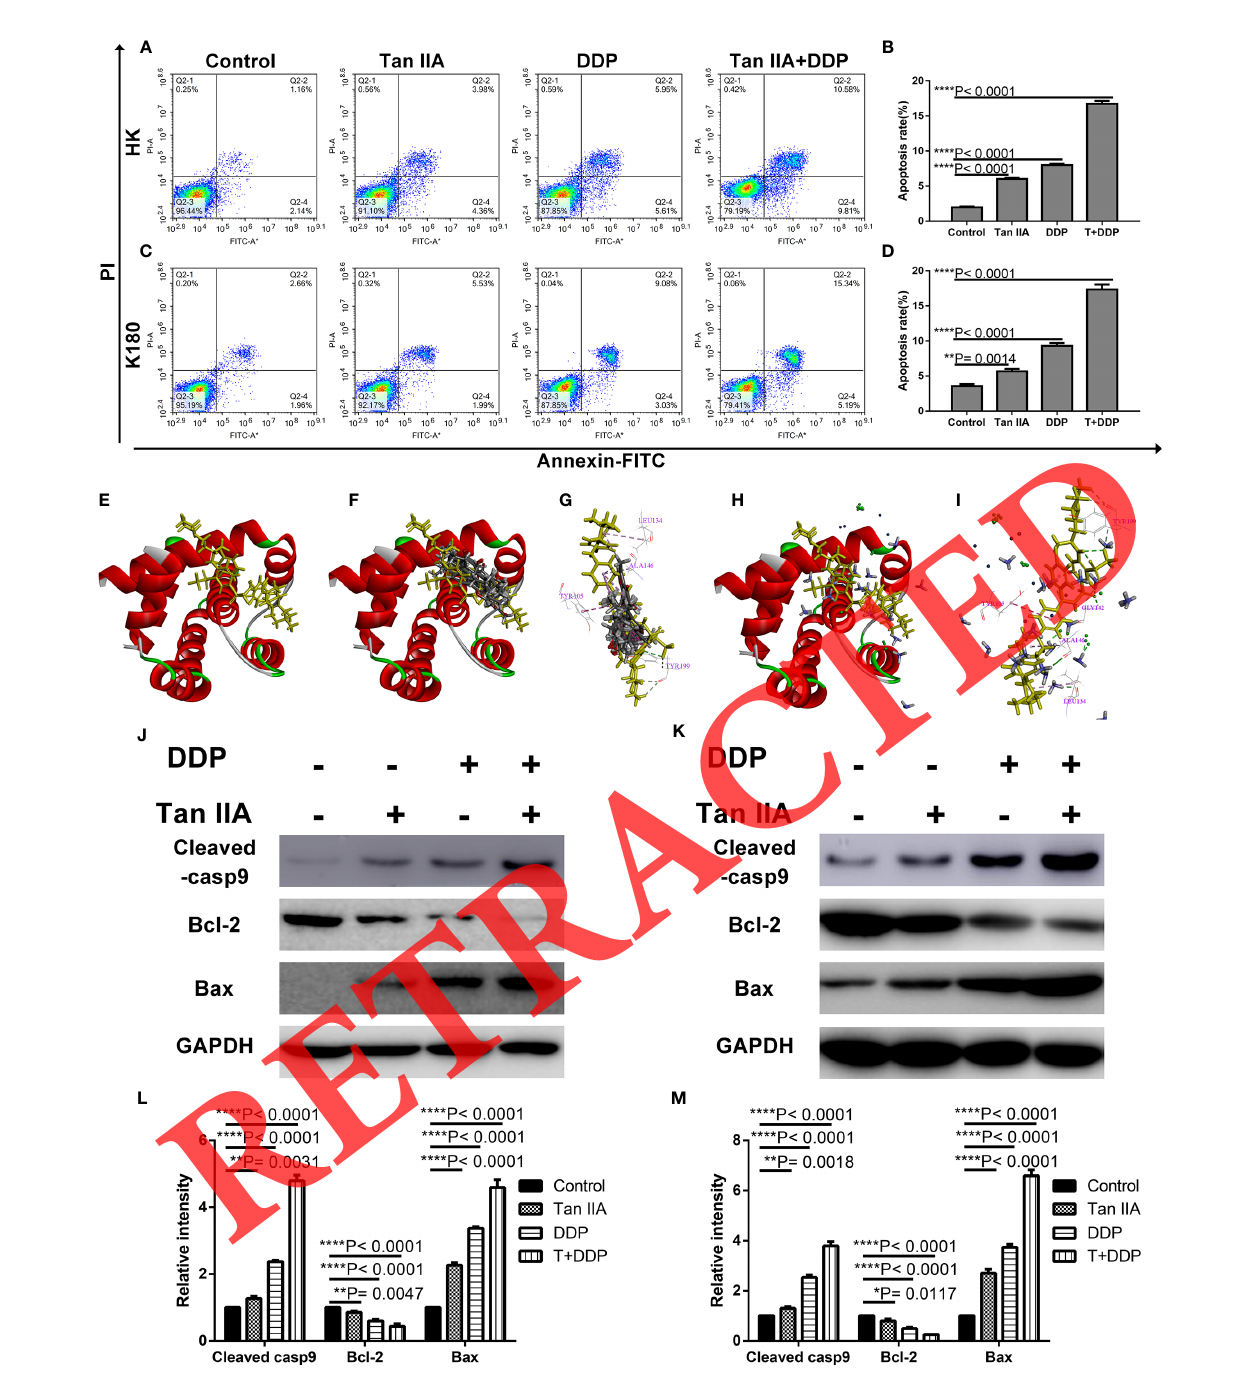
FIGURE 5 | Effect of Tan IIA, DDP alone and in combination on apoptosis. Representative pro fi les showing apoptosis in HK (A) or K180 cells (C) treated with 6 m M Tan IIA, 3 m M DDP alone and 1 m M DDP and 2 m M Tan IIA in combination for 48 h. Data represent the cell population of cell cycle arrest of HK (B) and K180 (D) cells. The 3D crystal structure of human Bcl-2 with an endogenous ligand (PDB-ID: 4lvt) (E) . Ten random poses of Tan IIA docked into the active site of 4lvt (F) . The binding modes of Tan IIA in Bcl-2: at least four residues involved in the interactions in ten random poses, TYR 199 (H-bonds) and TYR 105, LEU 134, ALA 146 ( p - p interaction) (G) . Ten random poses of DDP docked into the same active site of 4lvt (H) . The binding modes of DDP in Bcl-2: at least fi ve residues involved in the interactions in ten random poses, ASN 142, TYR 199 (H-bonds) and TYR 105, LEU 134, ALA 146 ( p - p interaction) (I) . Protein expression levels of Cleaved casp9, Bcl-2, Bax, and GAPDH of HK (J) and K180 (K) cells following 48 h treatment with 6 µM Tan IIA, 3 µM DDP alone and 1 µM DDP and 2 µM Tan IIA in combination. Histograms depict the relative gray value of the related proteins measured using Image J (L, M) . All data are shown as the mean SD of three independent experiments. ** P < 0.01 or **** P < 0.0001 versus the control